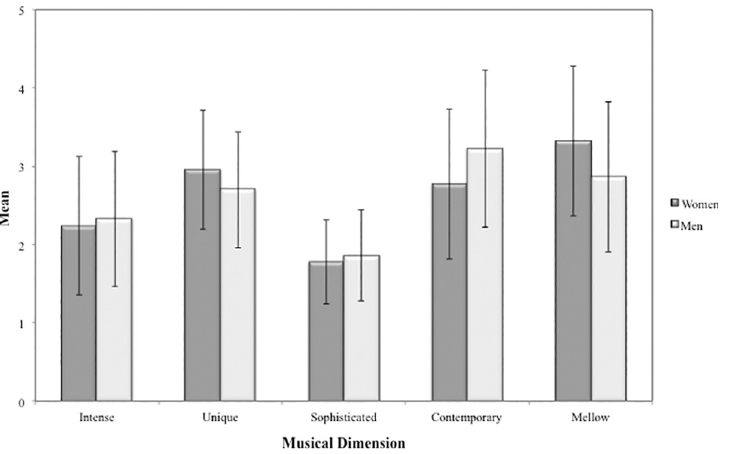
Fig 3. Descriptive statistics for musical preferences regarding gender.